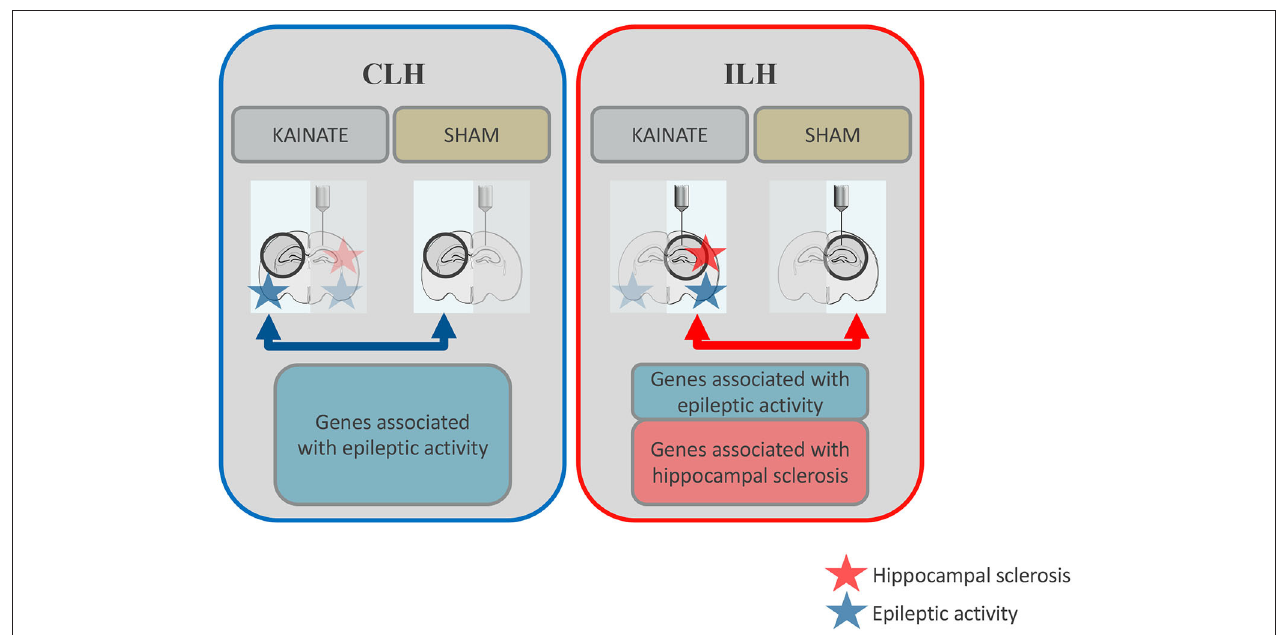
FIGURE 1 | Schematic overview: Differential gene expression in the contralateral and ipsilateral hippocampi at 24h after status epilepticus induction. Both the ipsilateral and contralateral hippocampi were exposed to epileptic activity (upon a status epilepticus lasting several hours), but only the ipsilateral hippocampus gradually develops morphological alterations such as reactive gliosis and neuronal death (hippocampal sclerosis). In this study, gene expression was compared between epileptic mice (kainate injected over the right, ipsilateral, hippocampus) and sham mice (saline injected at the same location) for the contralateral hippocampus (CLH, blue arrow ). This data was compared to previous data on gene expression from the ipsilateral hippocampus (ILH, red arrow ). Differentially expressed genes associated with epileptic activity are represented by the blue boxes . Differentially expressed genes potentially associated with morphological alterations typical of mesial temporal lobe epilepsy with hippocampal sclerosis (mTLE-HS) are represented by the red box .